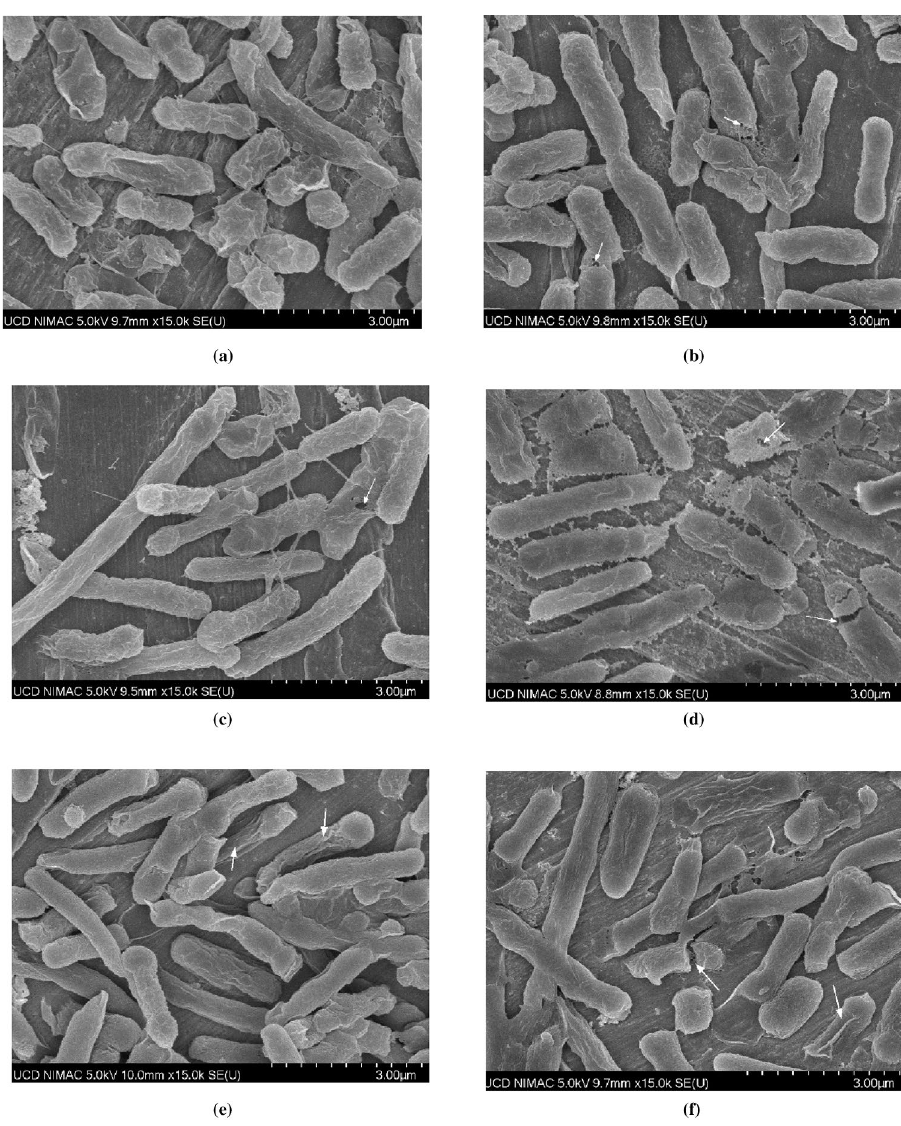
Figure 6. Scanning electron micrographs of 96 h E. coli biofilm—( a ) Untreated control; ( b ) 15 min AU treatment; ( c ) 30 min AAU treatment; ( d ) 3 min AAP treatment; ( e ) 5 min AAP treatment; ( f ) 10 min AAP treatment. White arrows indicate visibly deformed structures and